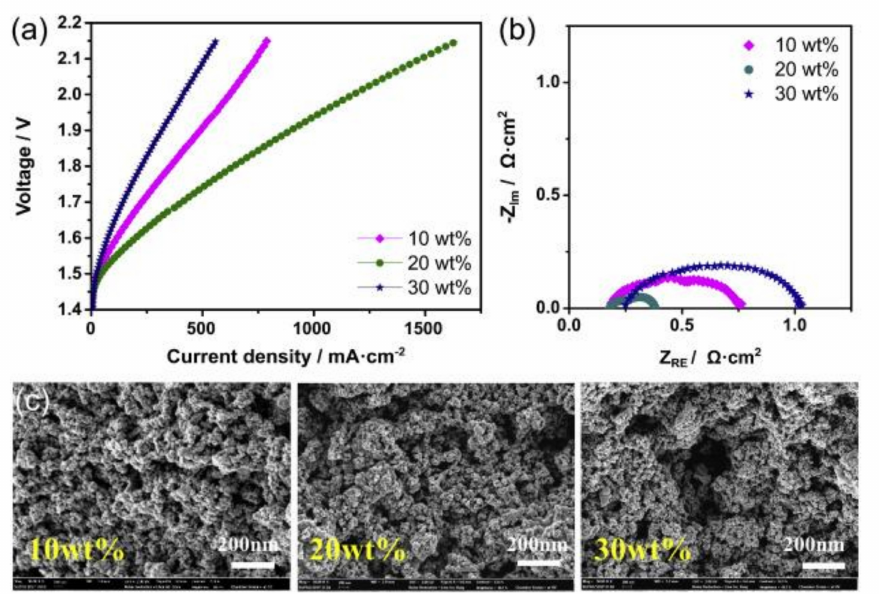
Figure 5. ( a ) Polarization curves and ( b ) Nyquist plots acquired at 50 ◦ C for AEMWEs with several ionomer contents (10, 20, and 30 wt%). ( c ) FE-SEM images of MEAs fabricated using different ionomer contents. The feed condition was 1.0 KOH solution in both electrodes with a flow rate of 1 mL min − 1 . Reprinted from [23] with permission from